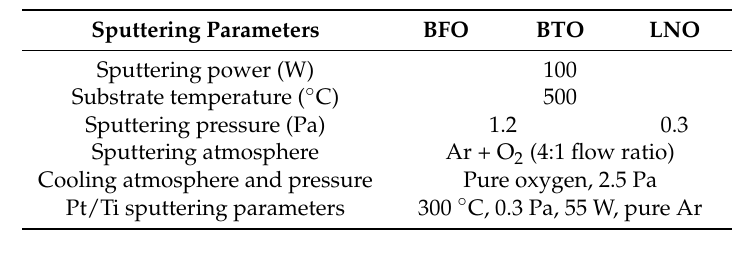
Table 1. Deposition Parameters of the Sputtering Process for BiFeO 3 /BaTiO 3 Bi-layer Films on SiO 2 /(100) Si Substrates.